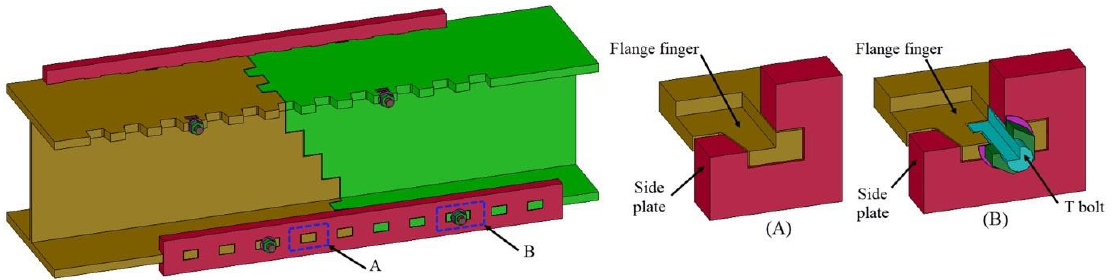
Figure 5. Side ISC with tapered fingers showing the assembled the connection components and details of the fingers and holes of the side plates.